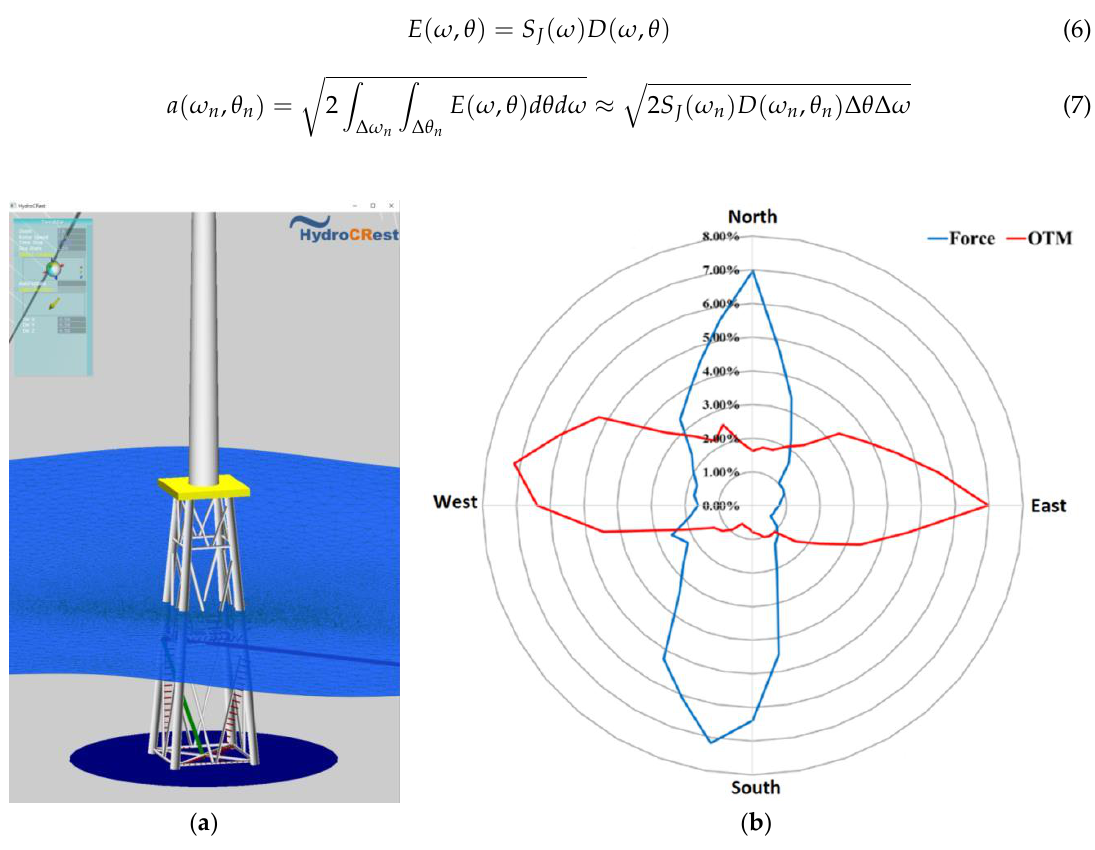
Figure 4. ( a ) Schematic of the HydroCRest simulation window; ( b ) Probability distributions in percentage of the directions of the total force and moment (OTM).